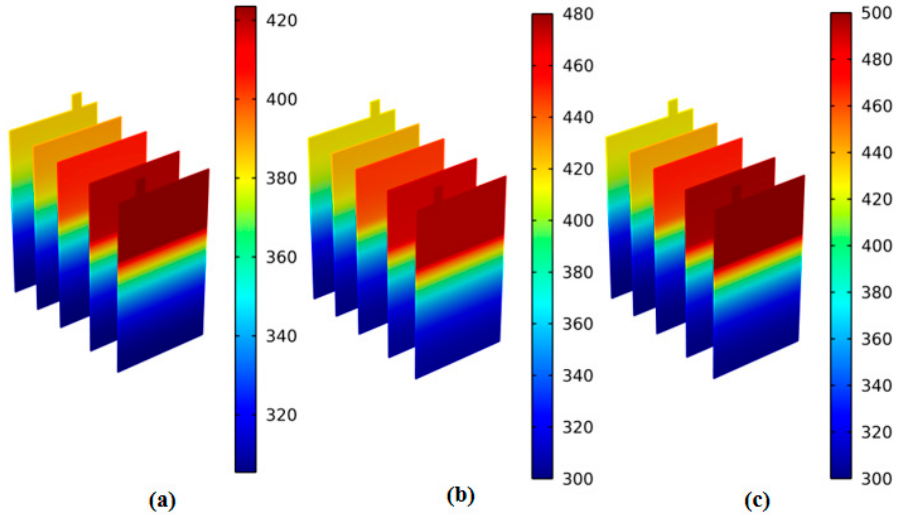
Figure 7. Temperature profiles of each part of the cell after heating for 300 s: ( a ) 423.15 K; ( b ) 473.15 K; and ( c ) 523.15 K.